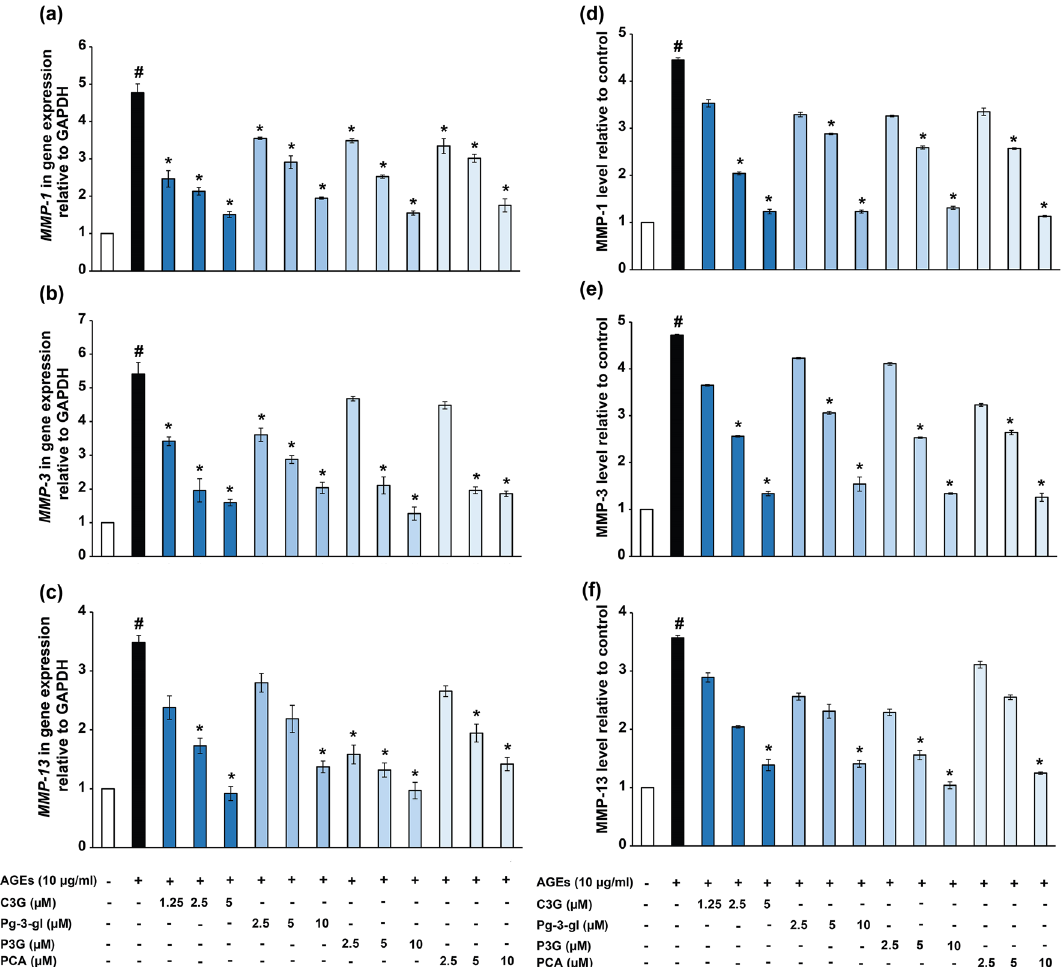
Figure 3. Effect of C3G, Pg-3-glc, P3G and PCA on AGEs induced HACs. The mRNA expression of MMP-1 ( a ), MMP-3 ( b ), MMP-13 ( c ) and protein expression of MMP-1 ( d ), MMP-3 ( e ) and MMP-13 ( f ) were analyzed after 24 h treatment by quantitative real-time PCR and ELISA assay, respectively. Data are expressed as the average mean ± S.D. of triplicate experiments. # p < 0.05 compared to untreated group, * p < 0.05 compared to AGEs treated alone.